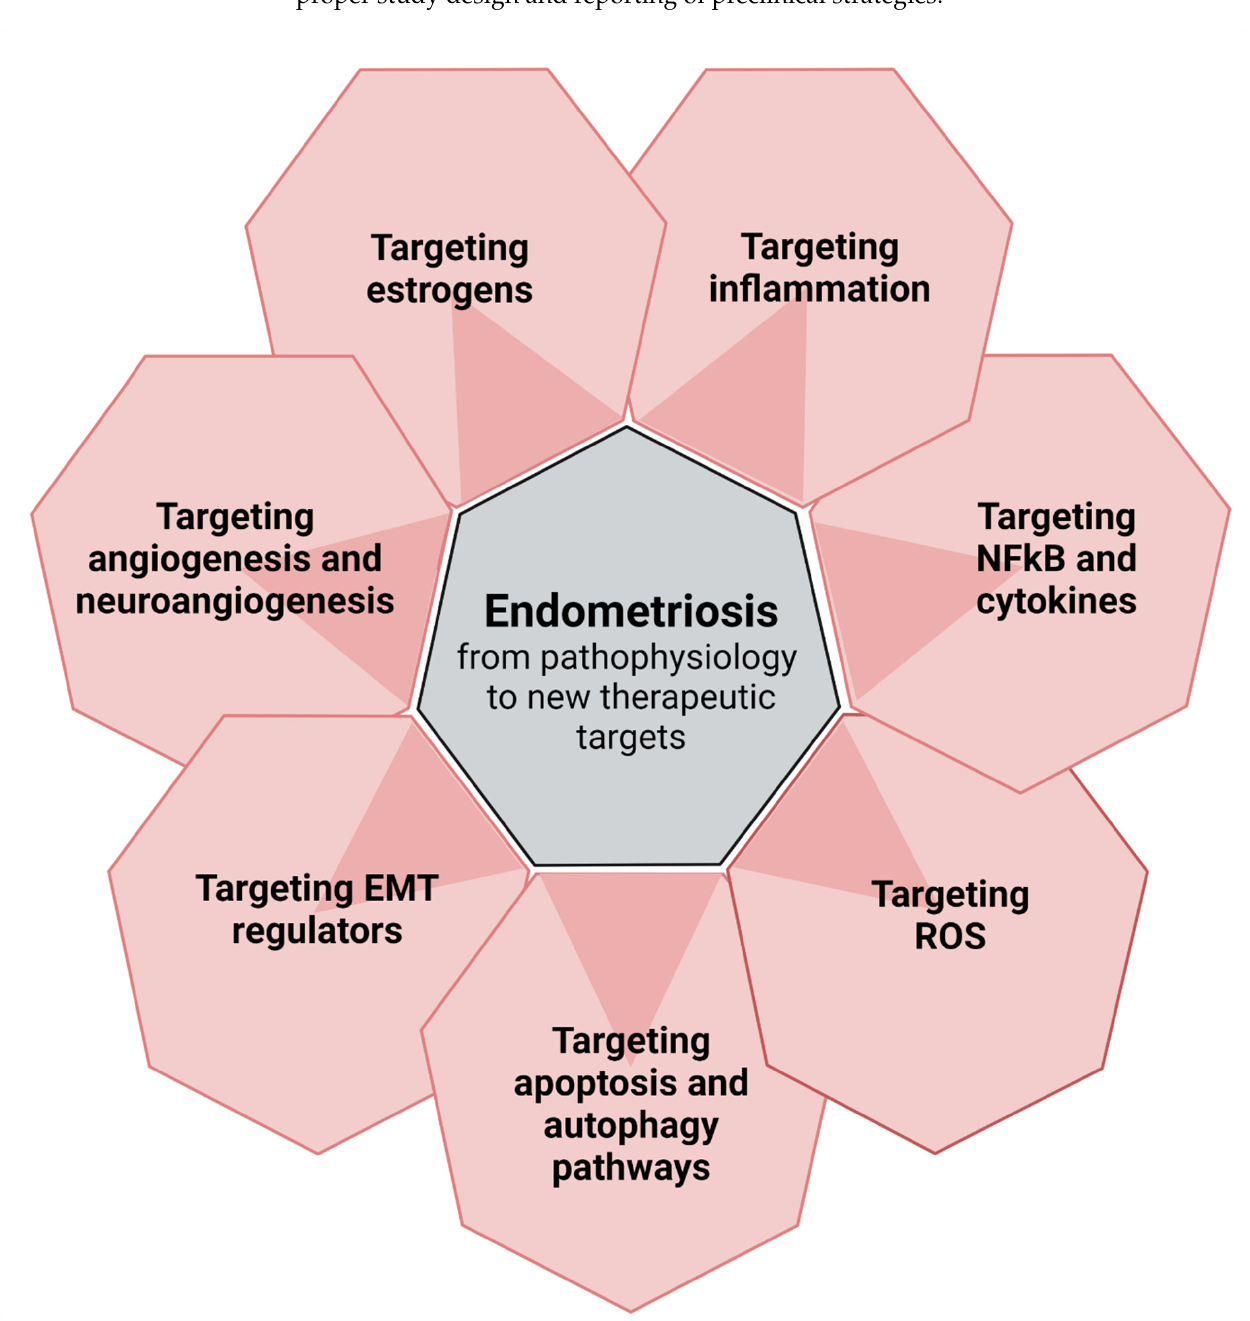
Figure 1. From pathophysiology to new perspectives: targets for new therapies.